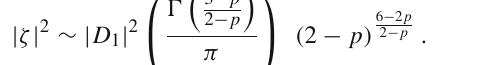
This formula agrees very well with numerical results pre- sented in